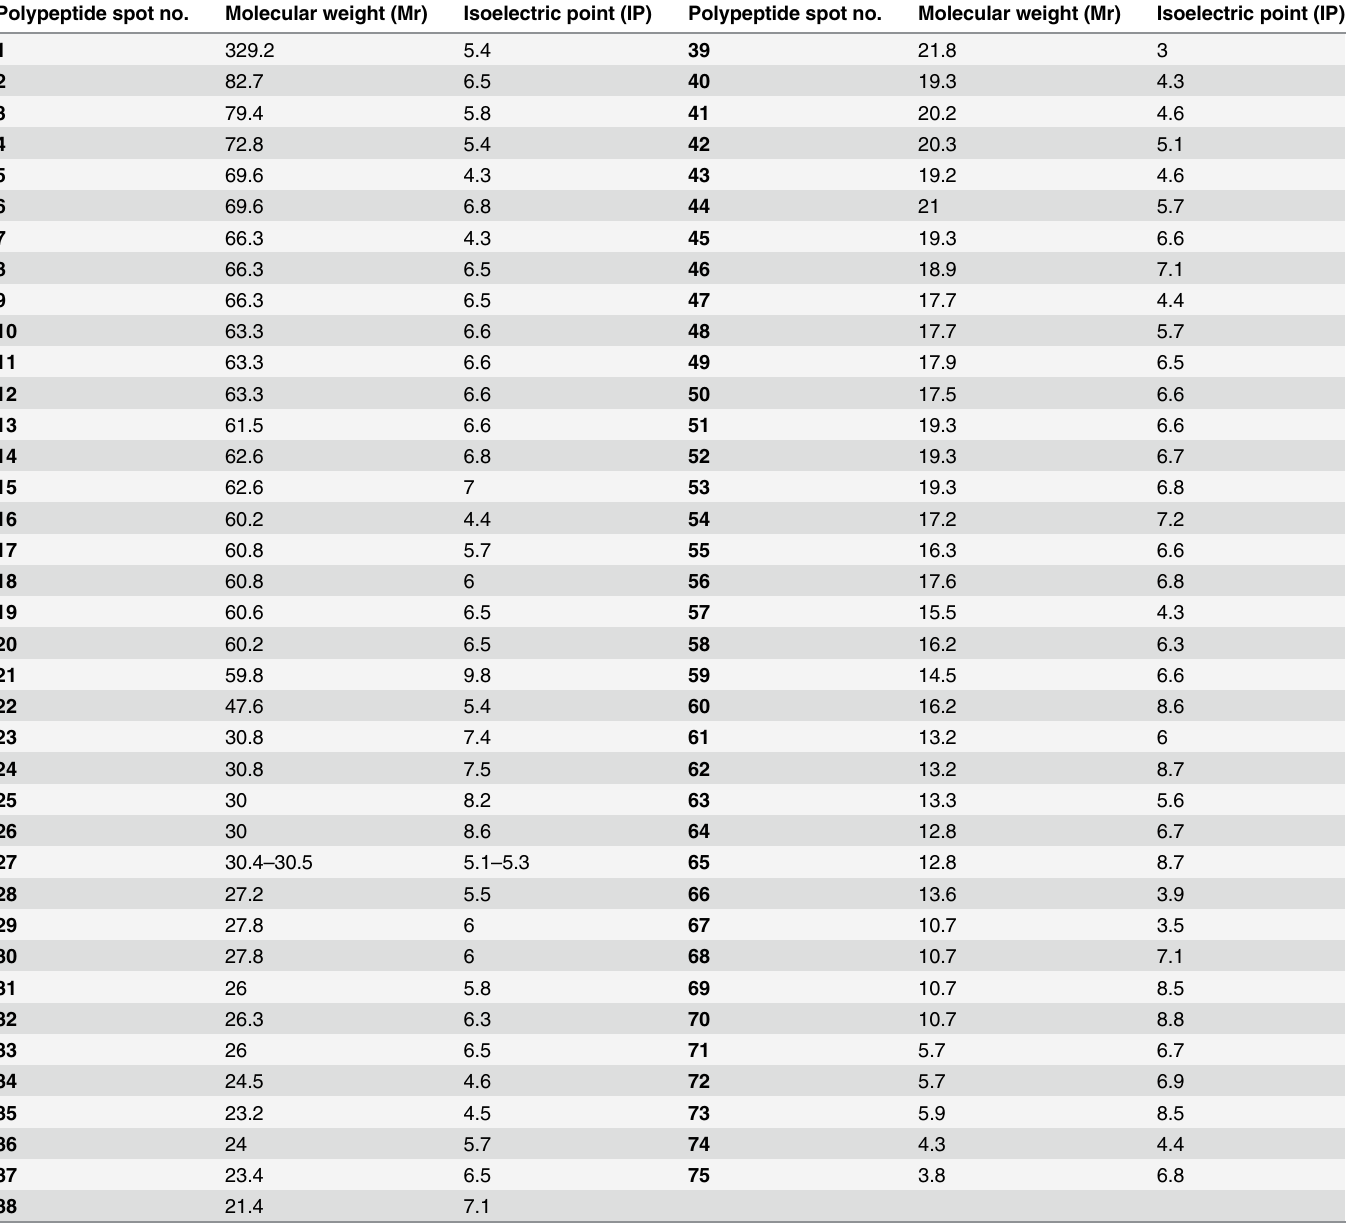
Table 3. T . gondii strain RH tachyzoite proteins (Fig. 7). Polypeptide spot